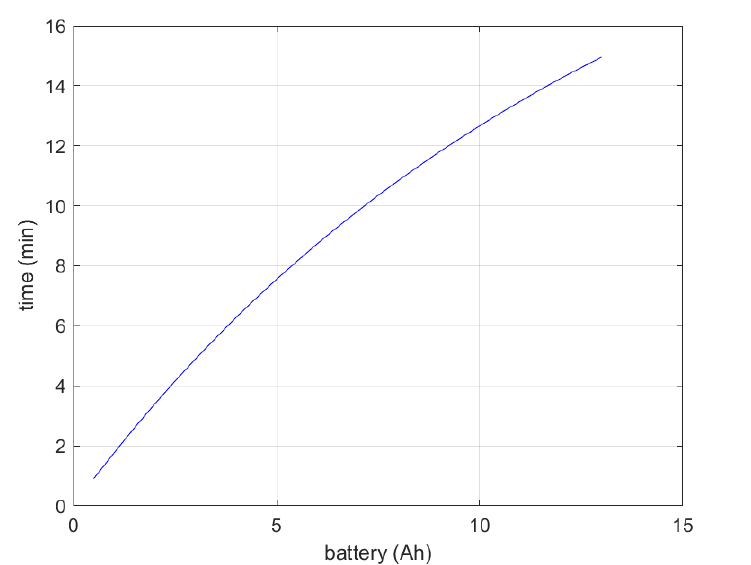
Figure 16. Electric-only flight time, including gas